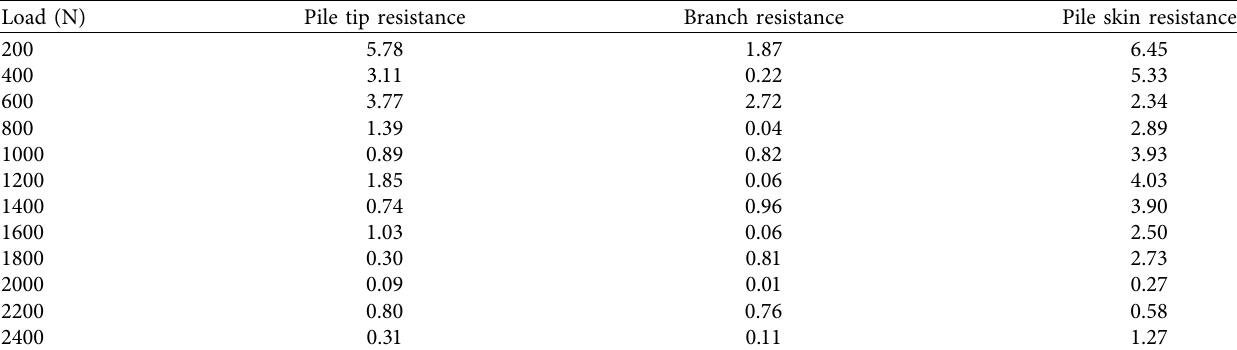
Table 5: Relative error analysis of pile bearing capacity composition (%).